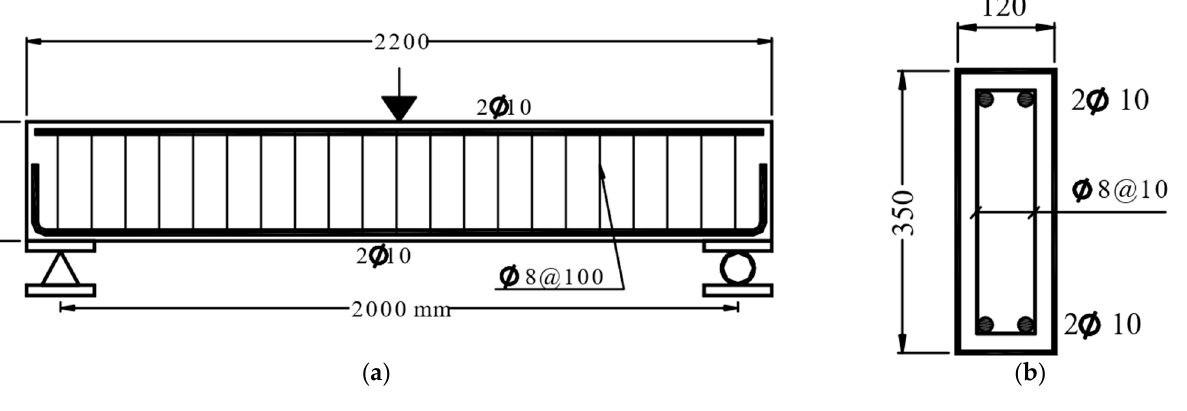
Figure 1. ( a ) Beam elevation; ( b ) Beam cross ‐ section.